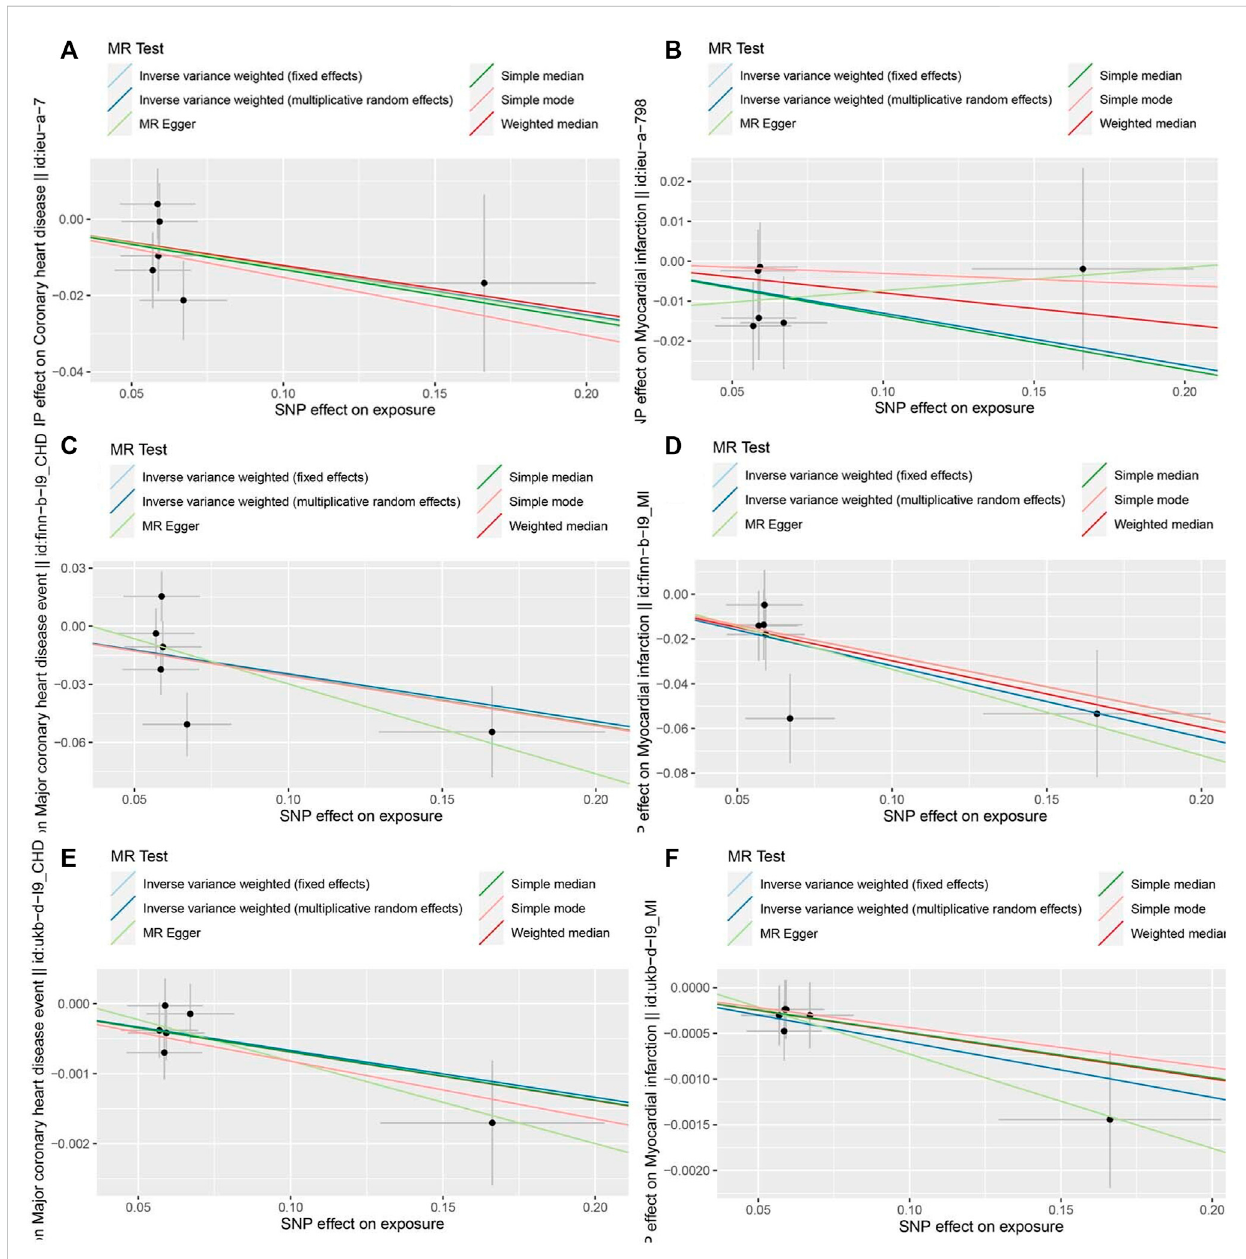
FIGURE 4 Scatter plots of the MR estimates for the association of RuminococcusUCG010 on CAD/MI. (A) . RuminococcusUCG010-CAD based on CARDIoGRAMplusC4D. (B) . RuminococcusUCG010-MI based on CARDIoGRAMplusC4D. (C) . RuminococcusUCG010-CAD based on FinnGen. (D)